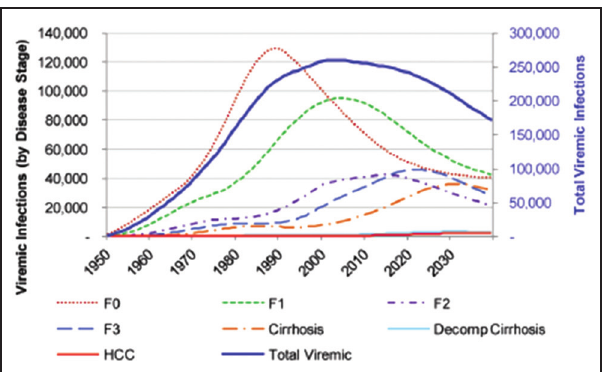
Figure 1) Modelled incidence of hepatitis C-related sequelae in Canada, 1950 to 2035. Estimates are not mutually exclusive. Reproduced with per- mission from Myers et al (18). Decomp Decompensated; HCC Hepatocellular